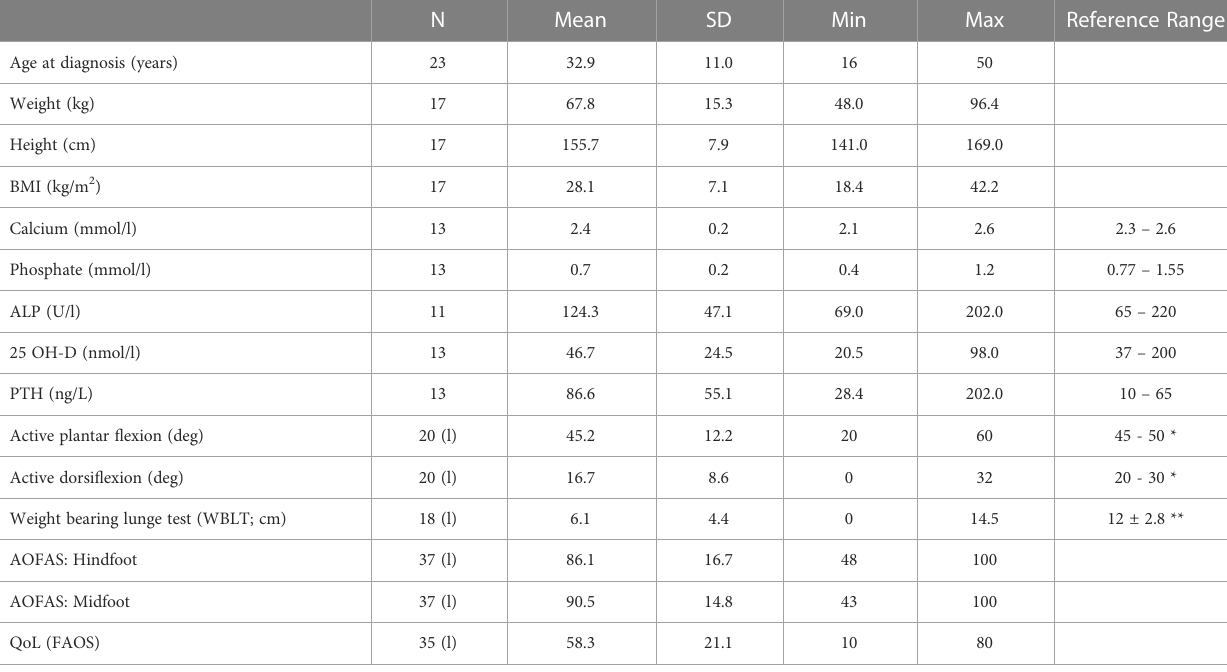
TABLE 1 Characteristics and laboratory fi ndings of included XLH